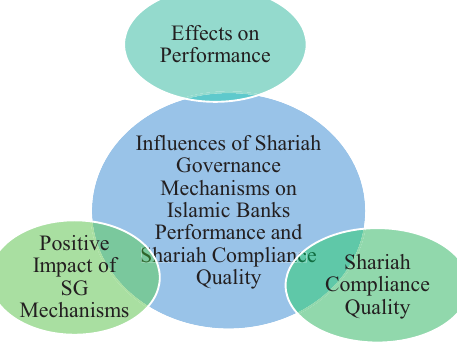
Figure 1. Theme of influences of Shariah governance mechanisms on Islamic banks performance and Shariah compliance